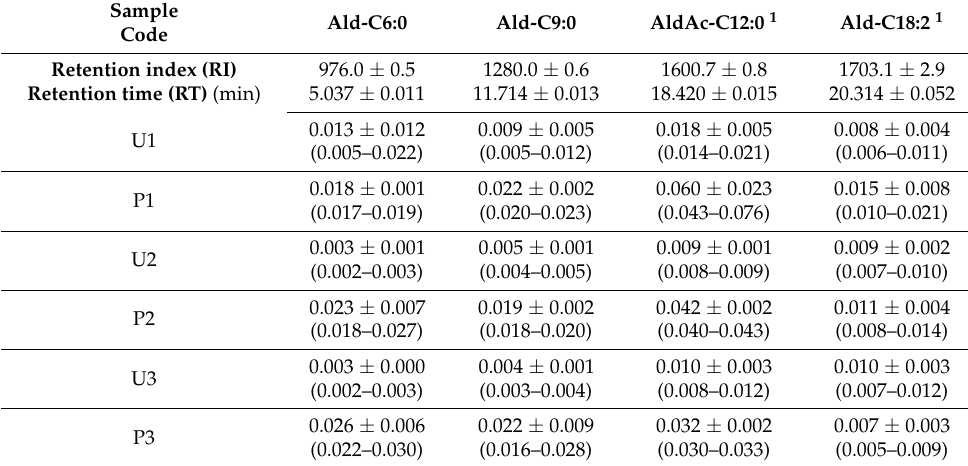
Table 5. Relative concentrations (%) of some degradation compounds (mainly aldehydes, as dimethy- lacetals) identified by GC-MS analysis in the lipid fraction from Mangalitza hard fat (unprocessed lipid layers—U1-U3 and thermally processed lipid layers—P1-P3). Ald-Cx:y stands for an aldehyde with x carbon atoms and y double bonds, while AldAc-Cx:y stands for an ω -formylated fatty acid with the same characteristics. Values are expressed as mean ± SD and data range (in